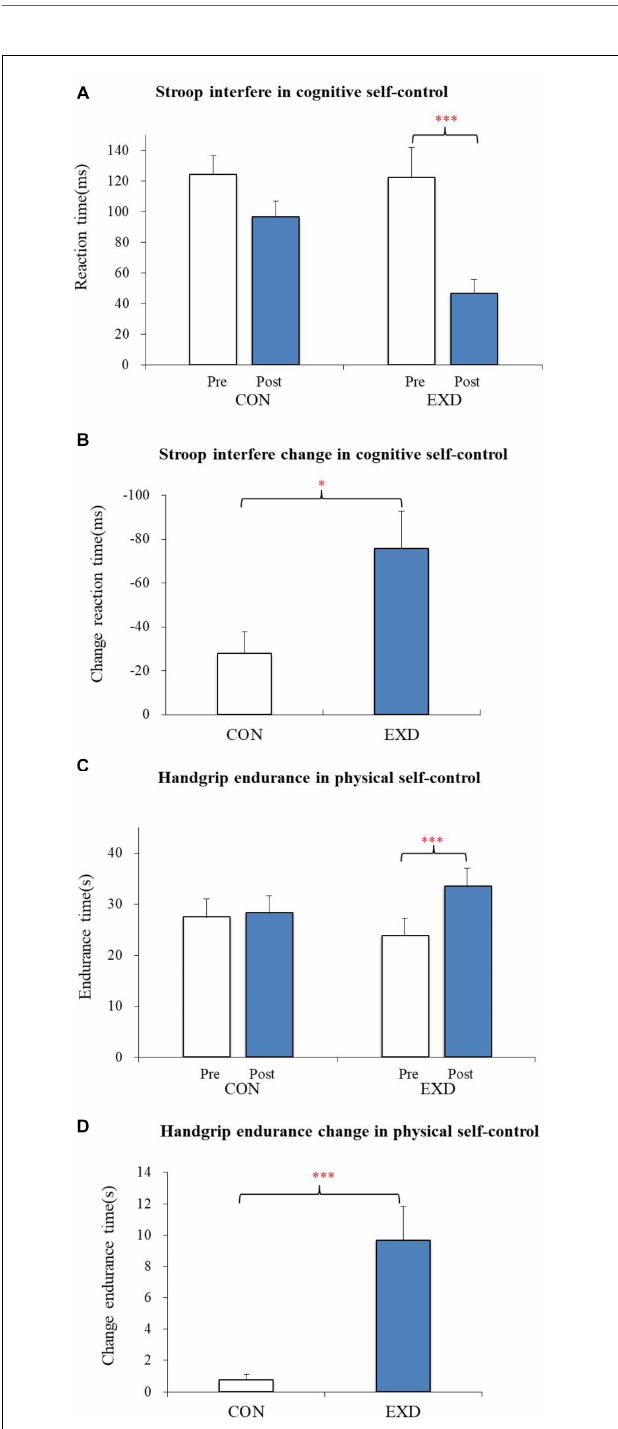
FIGURE 2 | (A) The mean difference in reaction times between incongruent and congruent conditions, indicating Stroop interference [i.e., (incongruent – congruent)] for the waitlist control group (CON) and combined exercise and dietary group (EXD). (B) Stroop-interference change [i.e., (post–pre)] in reaction time for Con and EXD groups. (C) Mean difference in handgrip-endurance times for CON and EXD groups. (D) Change in handgrip-endurance time [i.e., (post–pre)] for CON and EXD groups. All data are presented as the mean ± standard error. ∗ p < 0.05, ∗∗∗ p < 0.001.